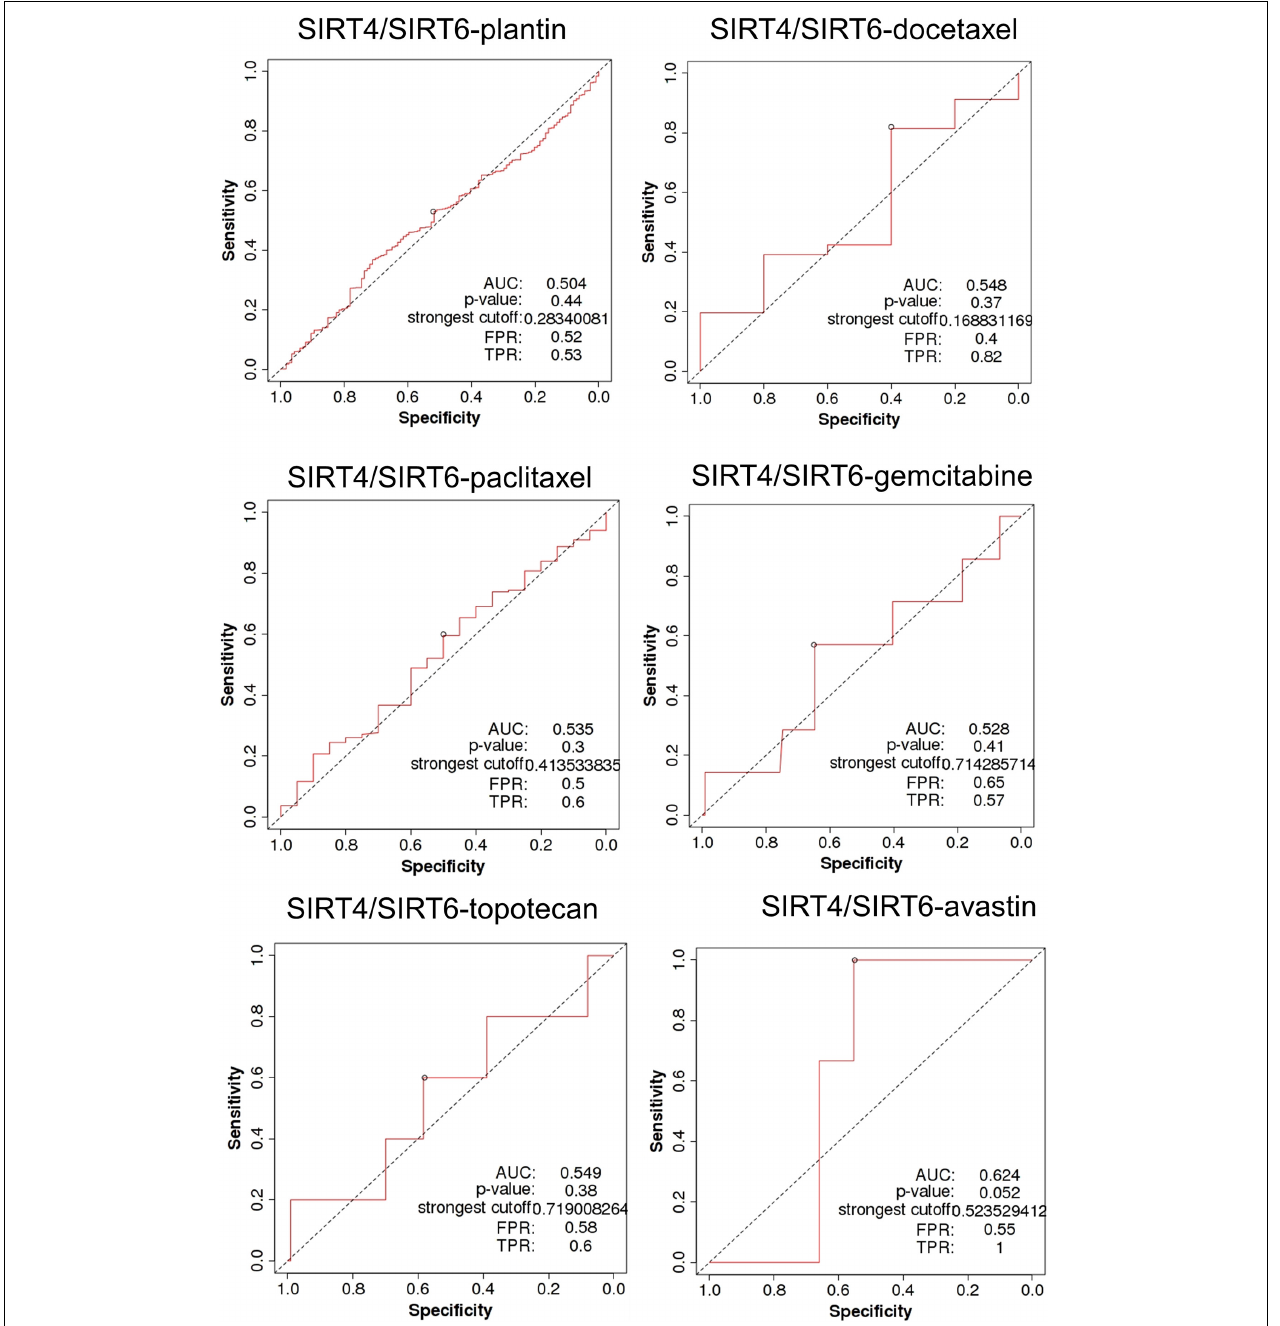
FIGURE 7 | Receiver operating characteristic (ROC) curve of the SIRT4/SIRT6 ratio in ovarian cancer patients under the indicated drug treatment for relapse-free survival time at 6 months. AUC, area under curve; FPR, false positive rate; TPR, true positive